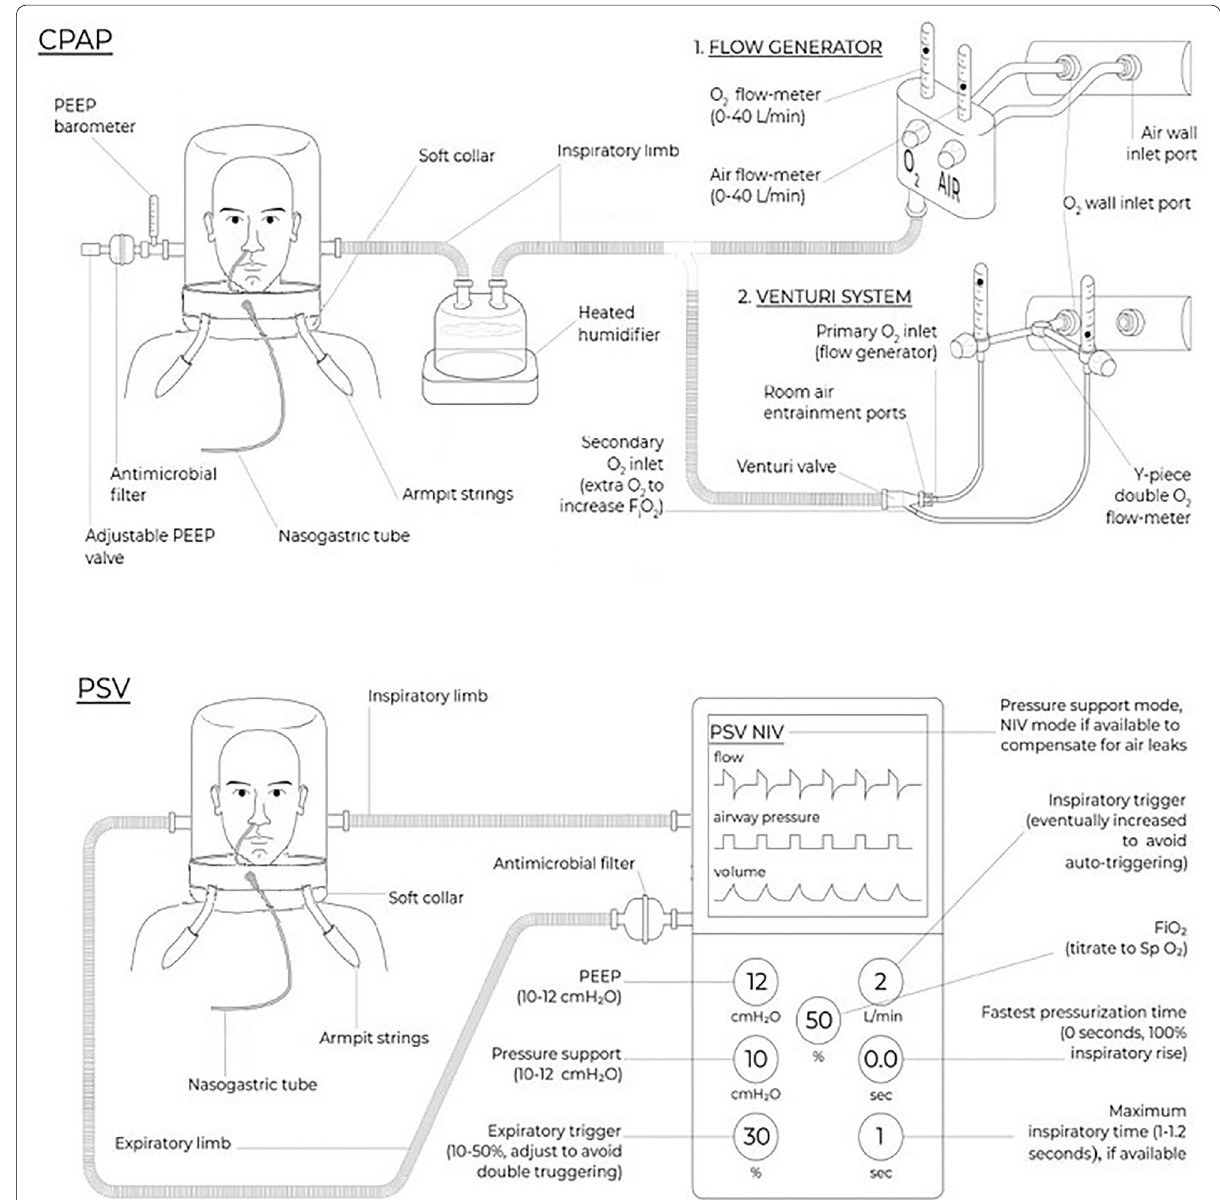
Fig. 2 Helmet interface and circuit set-up for CPAP and NIV. The helmet has a transparent hood and a soft collar that contacts the body at the neck and/or shoulders. It covers the head and neck without making direct contact with the patient’s face and it is fixed around the axillae. At least 2 ports are present, which are usually connected to two separate tubes for inhaled and exhaled gas (double-tube circuit). An antibacterial filter should be placed on the expiratory